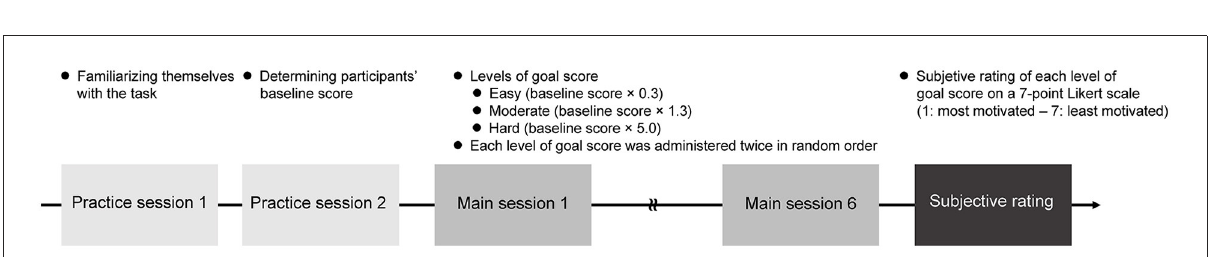
FIGURE2 Data collection procedure. Participants performed two practice sessions, one to familiarize themselves with the task and the other to determine the baseline score. In the main sessions, they performed a mental arithmetic task with three levels of goal scores: easy (baseline score × 0.3), moderate (baseline score × 1.3), and hard (baseline score × 5.0). Each level of goal score was administered twice in random order. After completing the task, the participants subjectively rated how motivated they were to achieve the goal score, using a 7-point Likert